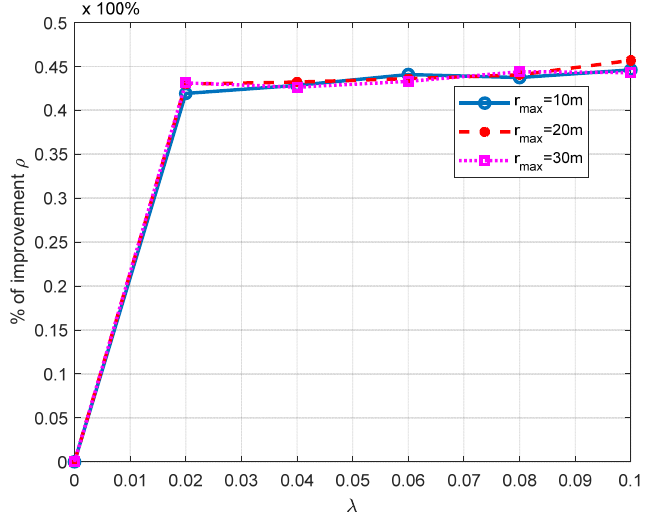
Figure 7. Improvement histogram for recursive localization using mean 4 ANs.